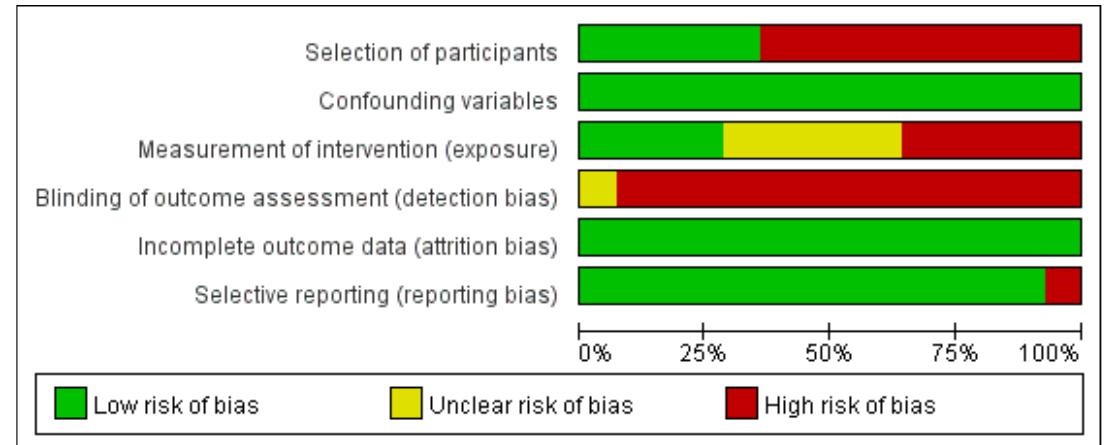
Figure 4. Risk of bias presented as percentages.